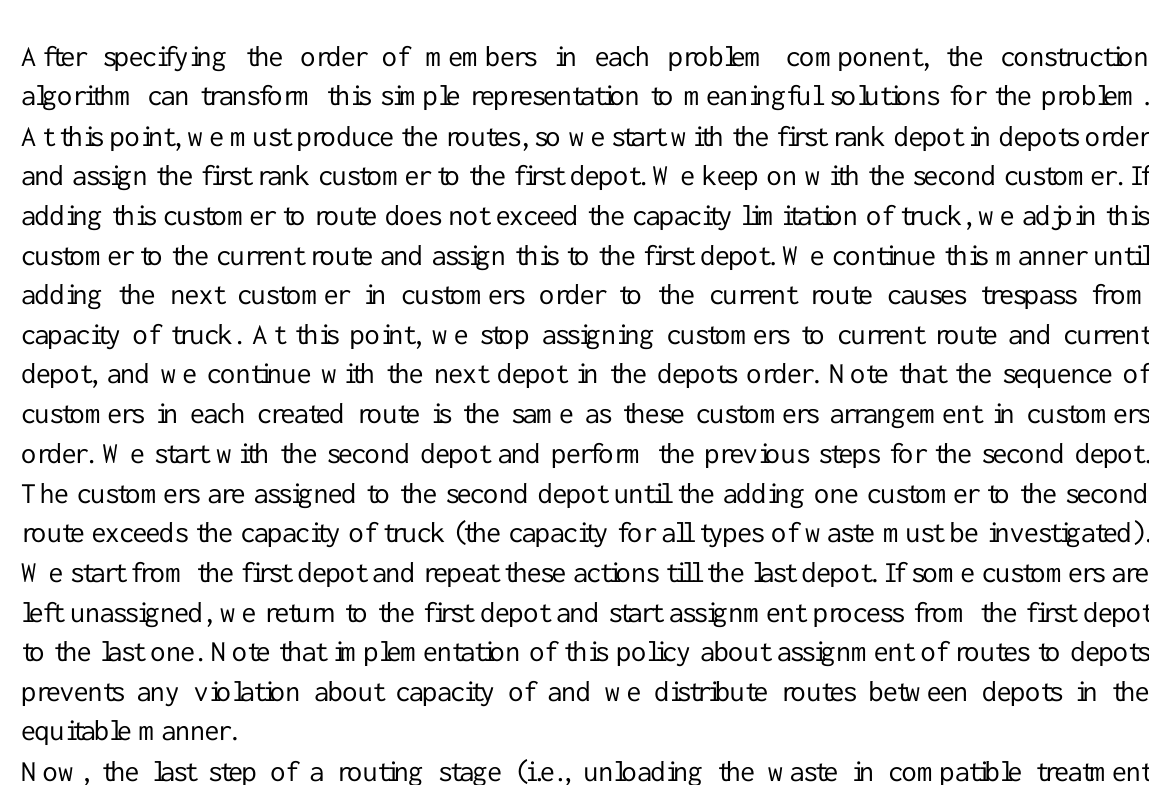
Fig 3 . Example of customers ordering in